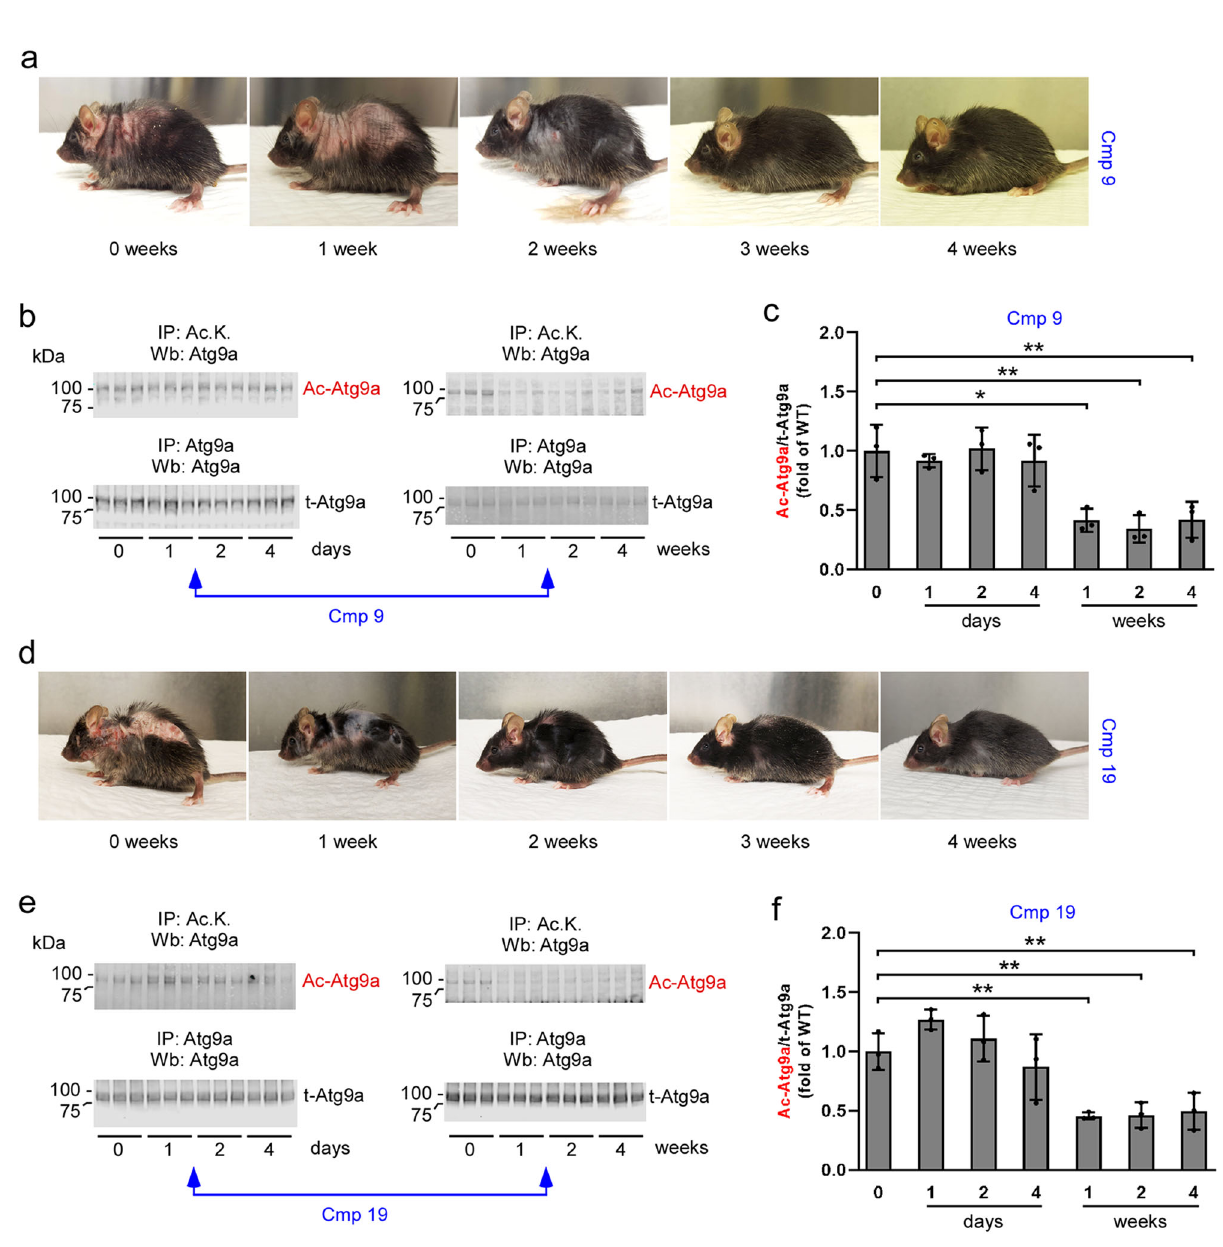
Fig. 6 Target engagement of Compound 9 and Compound 19 in AT-1 sTg mice. a Representative images to document rescue of the phenotype following Compound 9 treatment. The same AT-1 sTg mouse is shown. b and c Western blot showing levels of acetylated-Atg9a (Ac-Atg9a) in ER preparations from liver. Representative blots are shown in ( b ) while quantitation of results is shown in ( c ). d Representative images to document rescue of the phenotype following Compound 19 treatment. The same AT-1 sTg mouse is shown. e and f Western blot showing levels of acetylated-Atg9a (Ac-Atg9a) in ER preparations from liver. Representative blots are shown in ( e ) while quantitation of results is shown in ( f ). Bars represent mean ± SD. * p < 0.05, ** p < 0.005, *** p < 0.0005, # p < 0.0001 via ordinary two-way ANOVA plaque area percentage with Tukey ’ s multiple comparison test. Treatment started at 2-months of